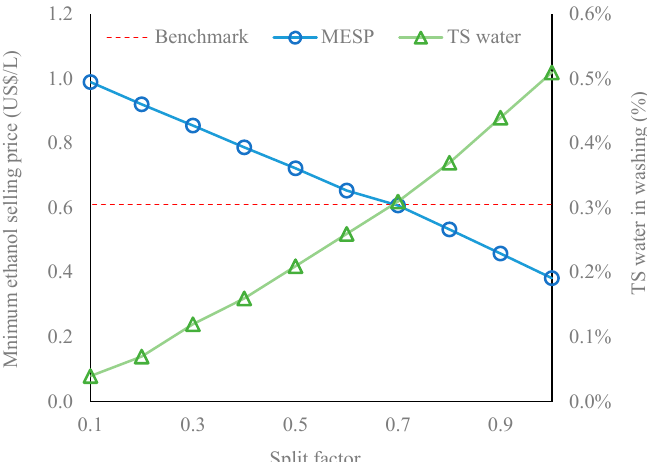
Figure 5. Minimum ethanol selling price (MESP) and total solids (TS) content in the water used in the conditioning step as a function of the split factor in the water recycling loop, expressed as the fraction of the washing liquid that was filtrated and recycled to conditioning. The feedstock price was assumed to be 20% of the wheat straw price.